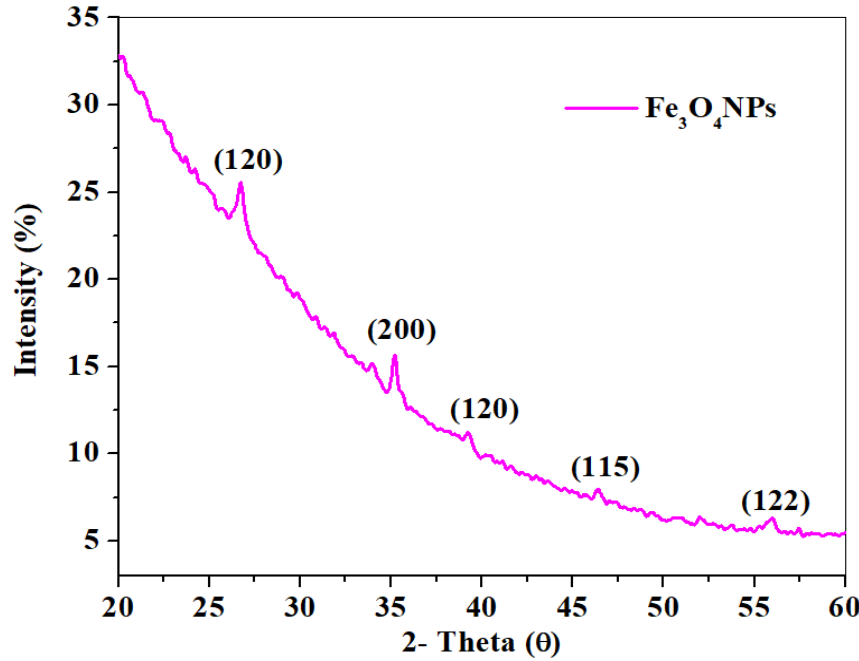
Figure 3. XRD pattern of mediated Fe 3 O 4 NPs using L. serica plant species leaf extract.